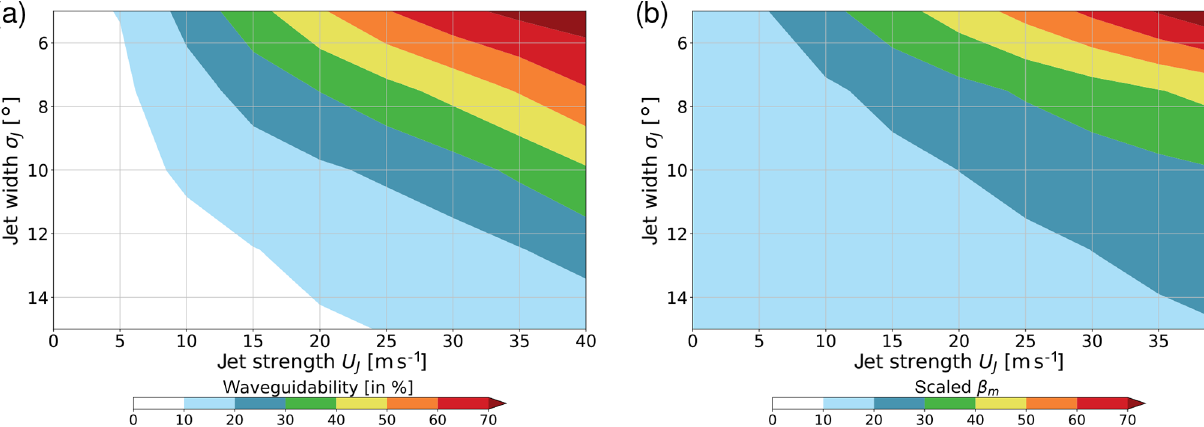
Figure 9. Results from the parameter sweep involving 5 × 9 model simulations with five different values for σ J and nine different values for U J : (a) waveguidability W and (b) scaled β M (see text for